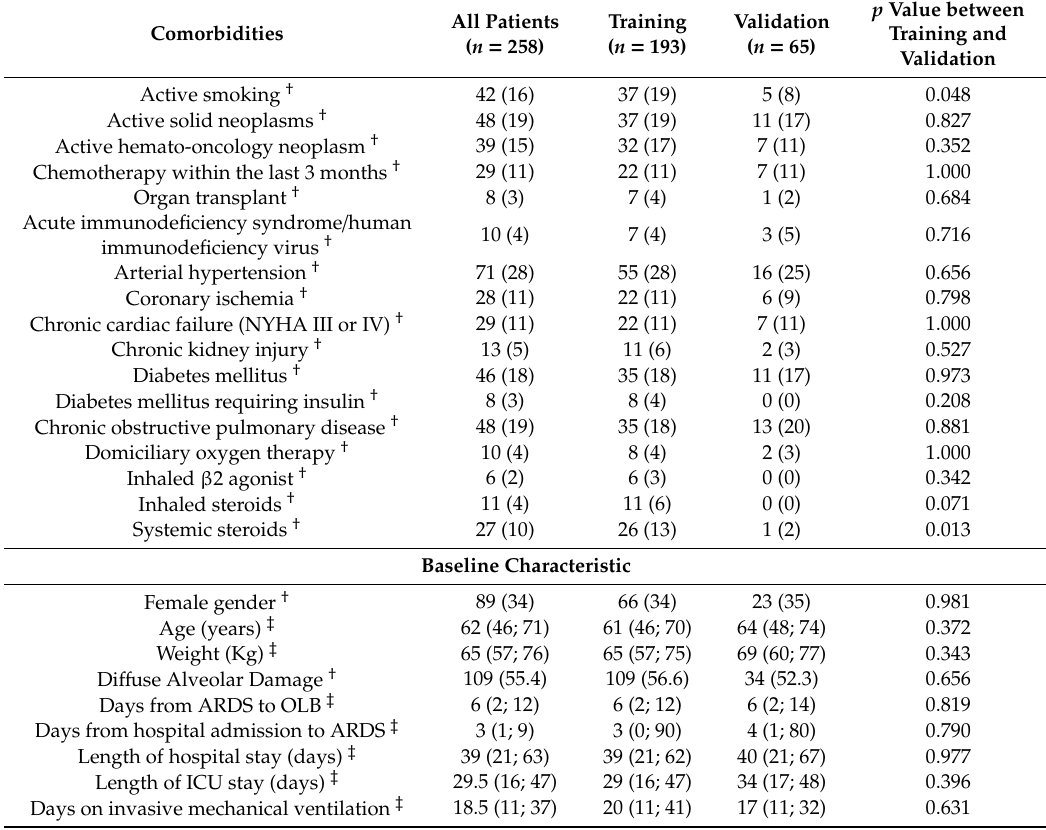
Table 1. Comorbidities and baseline characteristics of 258 patients with ARDS in the training and validation